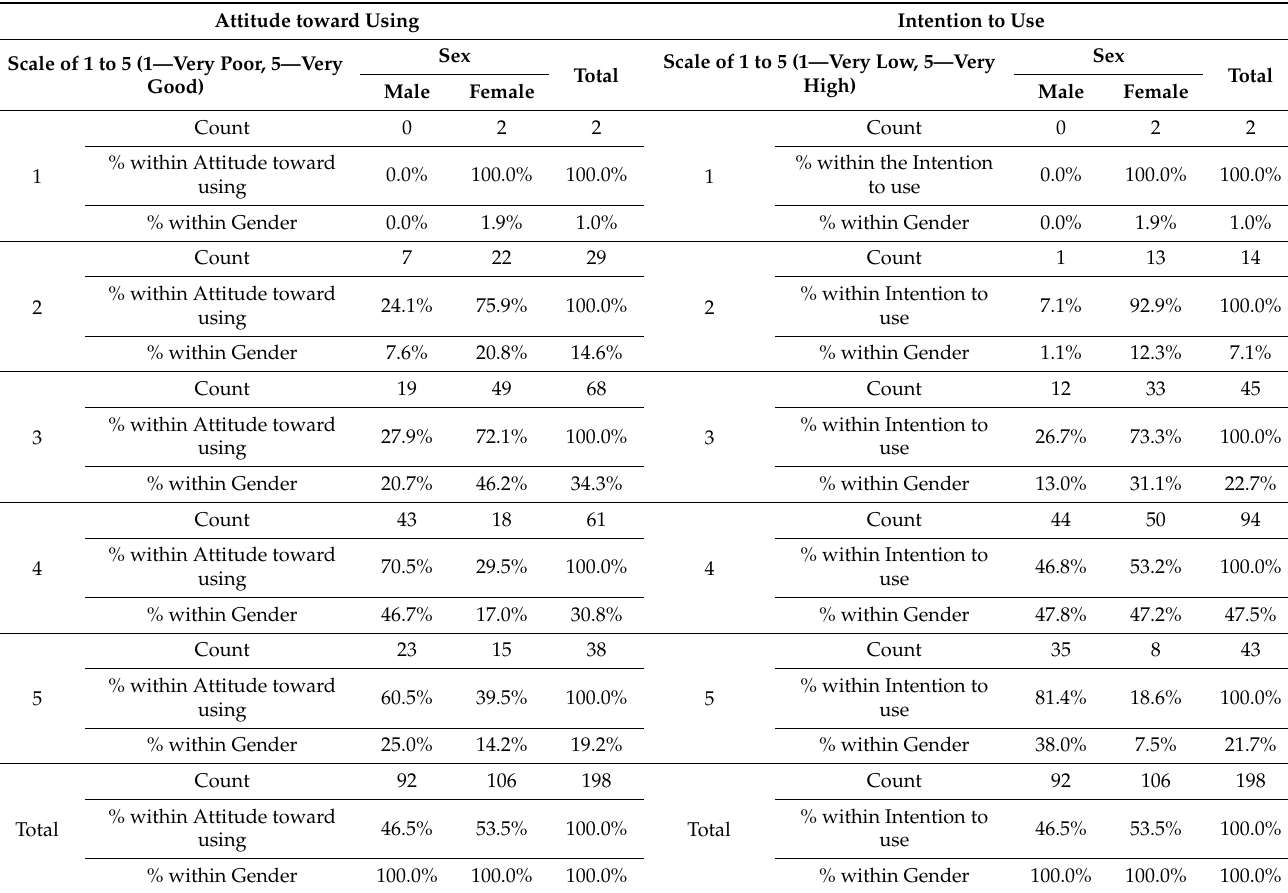
Table 6. The association between the variable gender and the variables attitude toward using and intention to use. Attitude toward Using